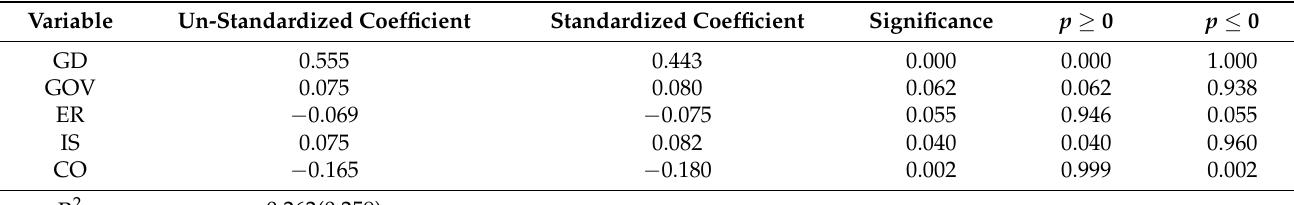
Table 6. Results of QAP regression